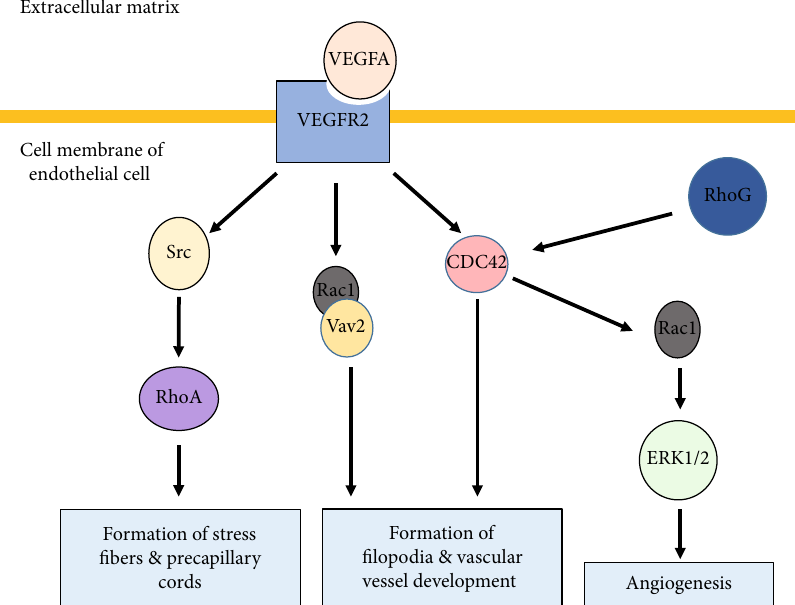
Figure 2: VEGF stimulates angiogenesis in endothelial cells in a Rho GTPase-dependent manner. The VEGFA/VEGF2 axis stimulates the activation of RhoA, Cdc42, and Rac1 leading to vascular development and formation of cytoplasmic migratory structures. Our lab has further proven that RhoG is a positive regulator of angiogenesis in vascular endothelial cells.